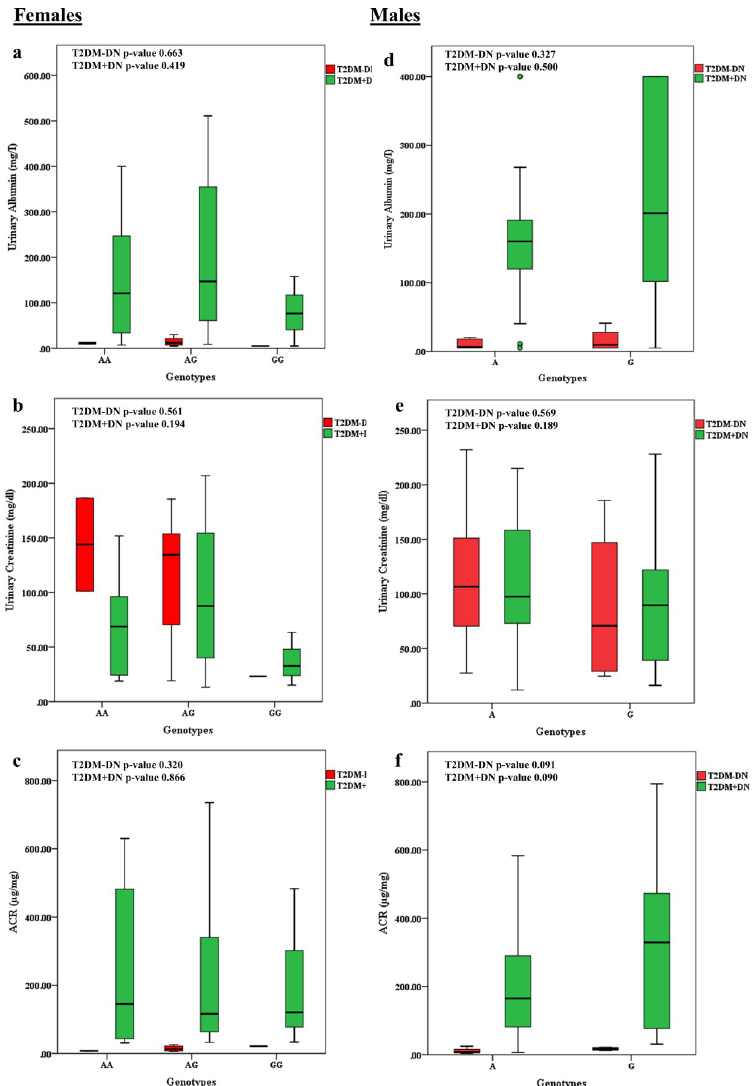
Fig 3. Association of G8790A ACE2 polymorphisms with the distribution of UAE, Urinary Creatinine and ACR data in T2DM patients with or without diabetic nephropathy. a-c) Distribution of data according to female genotypes (GG/AG/AA) d-f) Distribution of data according to male genotypes (A/G).